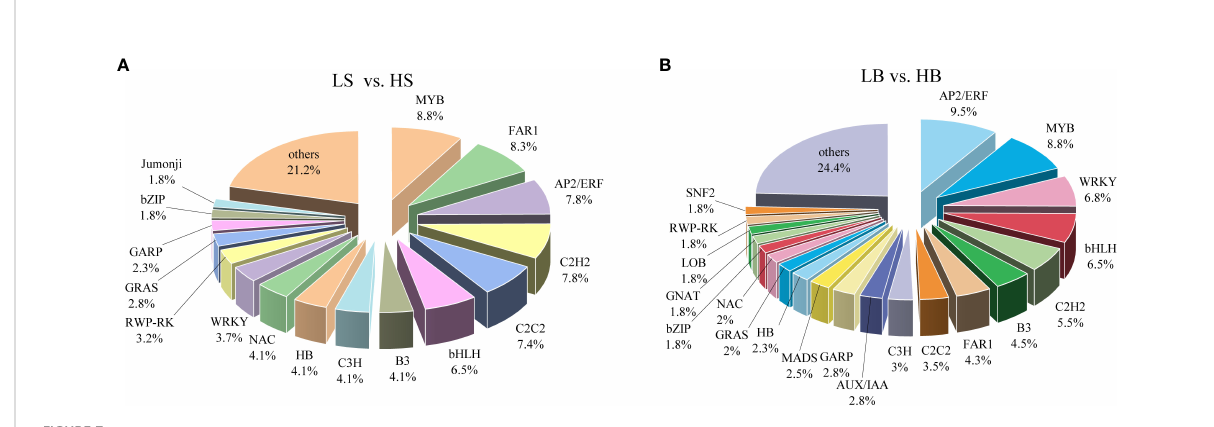
(Figure 7B; Table S3). The proportions of major TFs genes in H. ammodendron and H. persicum were high (ranging from 5% to 9.5%); these included FAR1, AP2/ERF, C2H2, bHLH, MYB, C2C2, and WRKY (Figures 7A, B). Among these TFs